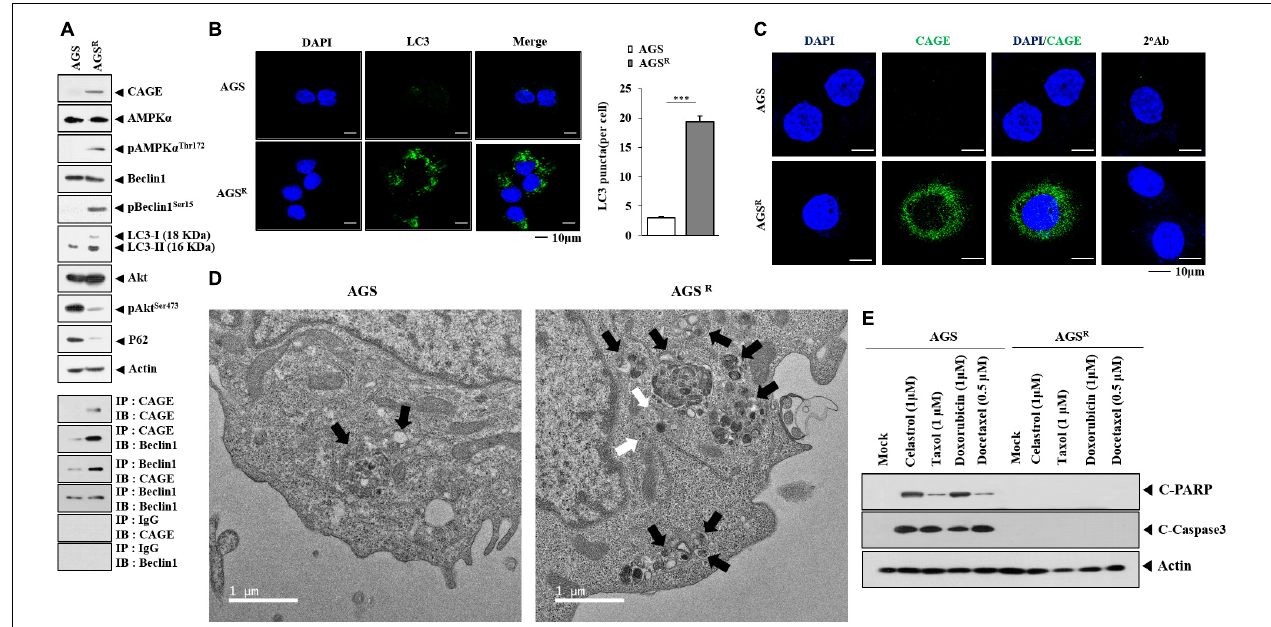
FIGURE 1 | Anticancer drug resistance is correlated with enhanced autophagy and antiapoptotic effects. (A) Cell lysates were subjected to immunoblot and immunoprecipitation. Representative blots of three independent experiments are shown. Immunofluorescence staining of LC3 (B) and cancer-associated gene (CAGE) (C) was performed. ***, p < 0.001. (D) Representative electron micrograph of AGS cells and AGS R cells is shown. The black arrows indicate autolysosomes. The white arrows indicate multivesicular bodies. (E) After 48 h of treatment, immunoblot was performed. C-PARP denotes cleaved PARP. Representative blots of three independent experiments are